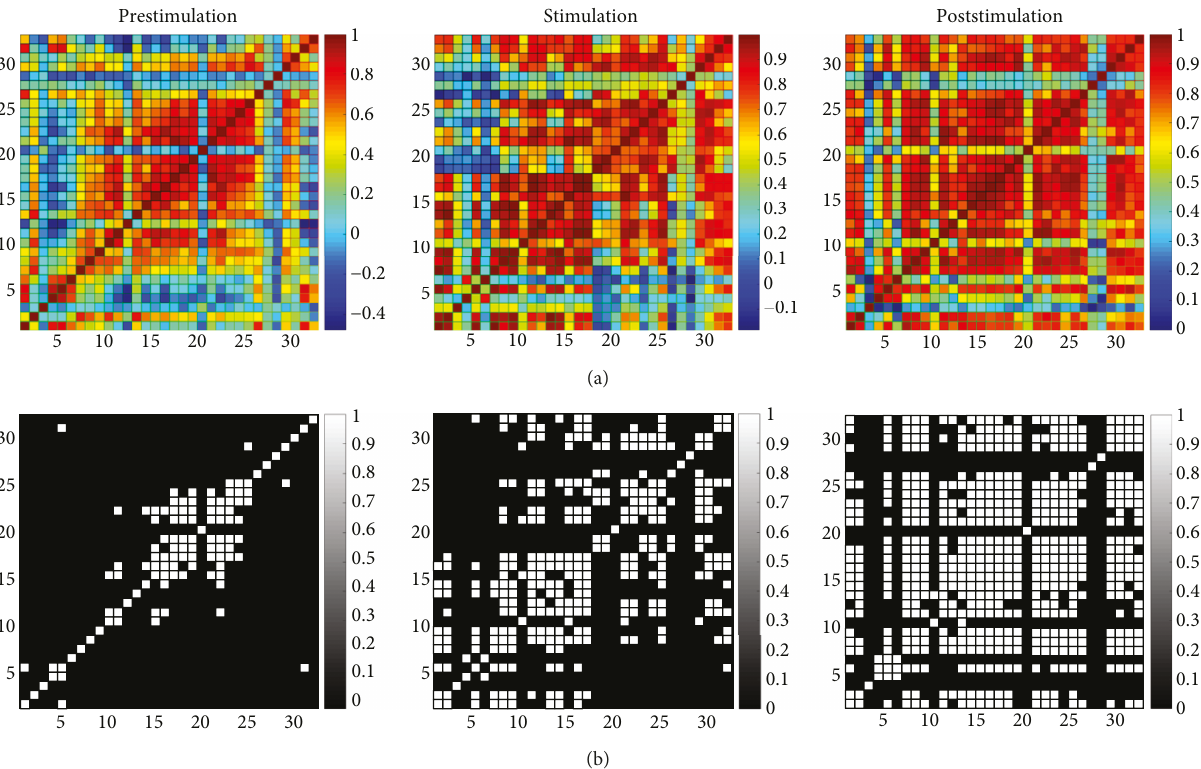
Figure 3: (a) Functional connectivity matrices for three stages and (b) binary matrices thresholded by Pearson ’ s correlation coe ffi cient